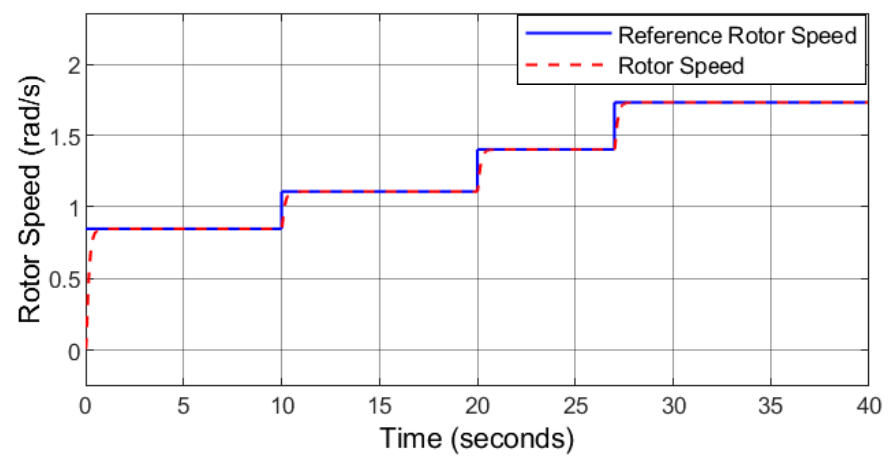
Figure 12. Scenario 3: tracking performance of the rotor speed.